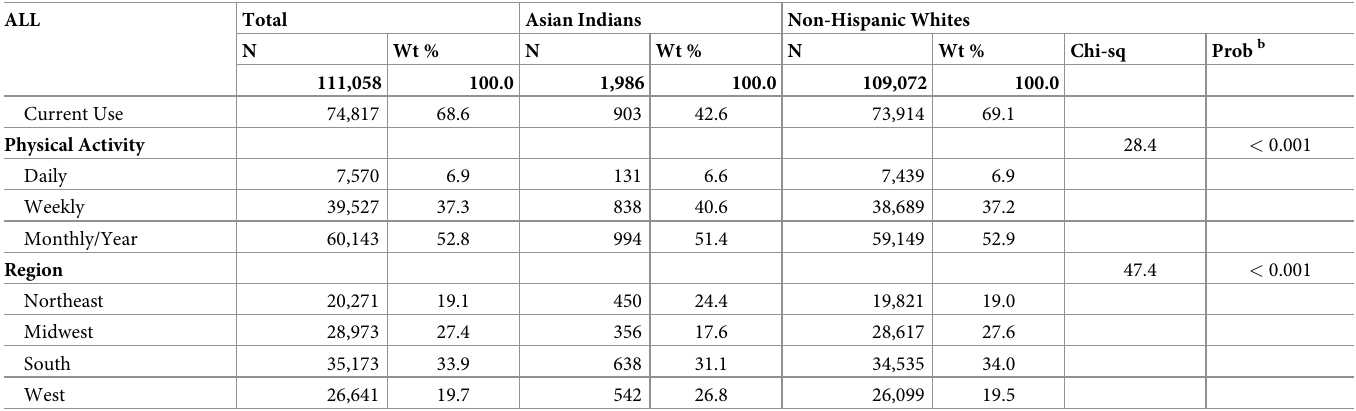
Unadjusted prevalence of diagnosed DM did not differ between Asian Indians and NHWs (7.5% vs 8.8%; P = .09). However, the age-sex adjusted prevalence of diagnosed DM was signif- icantly higher among Asian Indians (8.3% vs 5.8% for NHWs). Association of Asian Indian ethnicity to diagnosed diabetes Unadjusted odds ratios (UOR) and adjusted odds ratios (AOR) and their associated 95% confidence intervals (CI) from unadjusted and adjusted multivariable logistic regression analyses are summarized in Table 2. Without adjustments for age and sex, Asian Indians were as likely as NHWs to report diagnosed DM (UOR = 0.84, 95% CI: 0.68, 1.03; P = 0.0958). However, age-sex adjusted multivariable logistic regression indicated higher odds of reporting diagnosed DM among Asian Indians compared to NHWs (AOR = 1.39, 95% CI: 1.12, 1.71, P < 0.01). This association remained strong and significant after control- ling for variables such as age, sex, education, employment, poverty status, and other health insurance (AOR = 1.68, 95% CI: 1.36, 2.09, P < 0.01). In the fully adjusted model, Asian Indians were 1.5 times as likely as NHWs to report DM (AOR = 1.47, 95% CI: 1.16, 1.85, P <